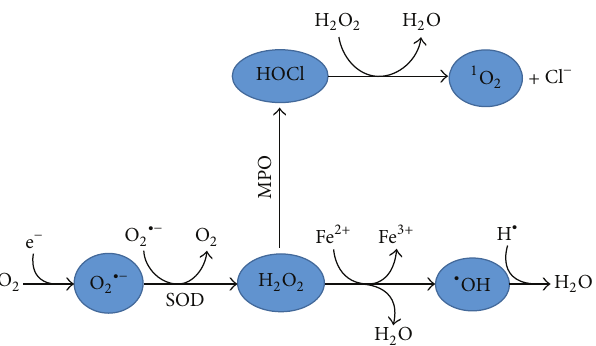
Figure 1: Production of ROS. The figure shows the pathway of ROS productioninthehumanbodywithvariousenzymesinvolved.SOD: superoxide dismutase; MPO: myeloperoxidase.